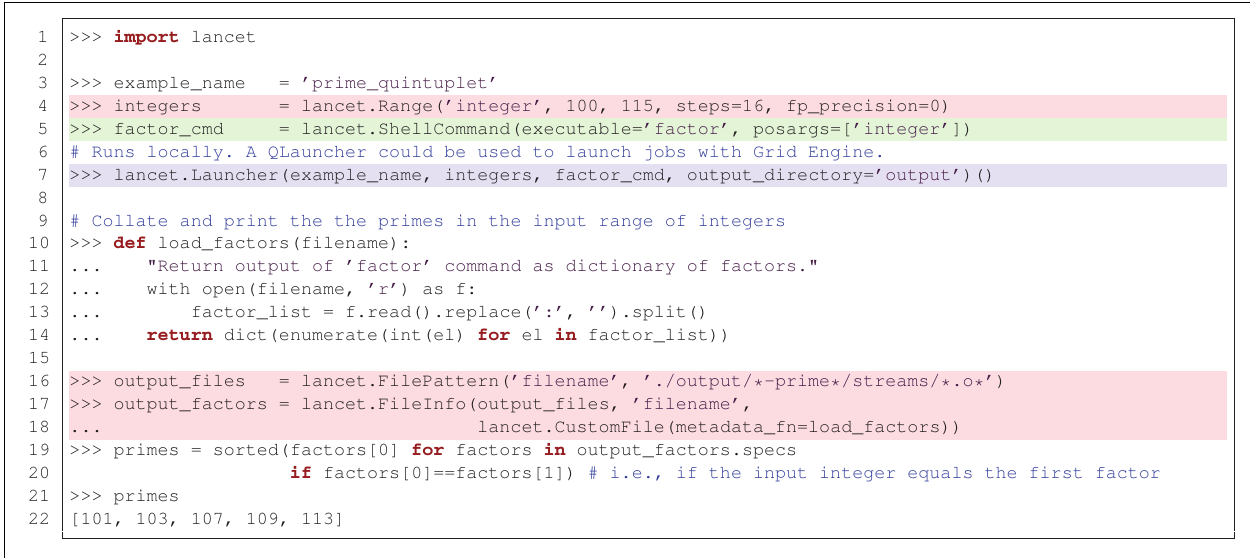
FIGURE 1 | A simple, end-to-end workflow using Lancet to factorize a range of integers, highlighted using the three colors used in the bullet points at the start of Section 2. This simple example factorizes a list of